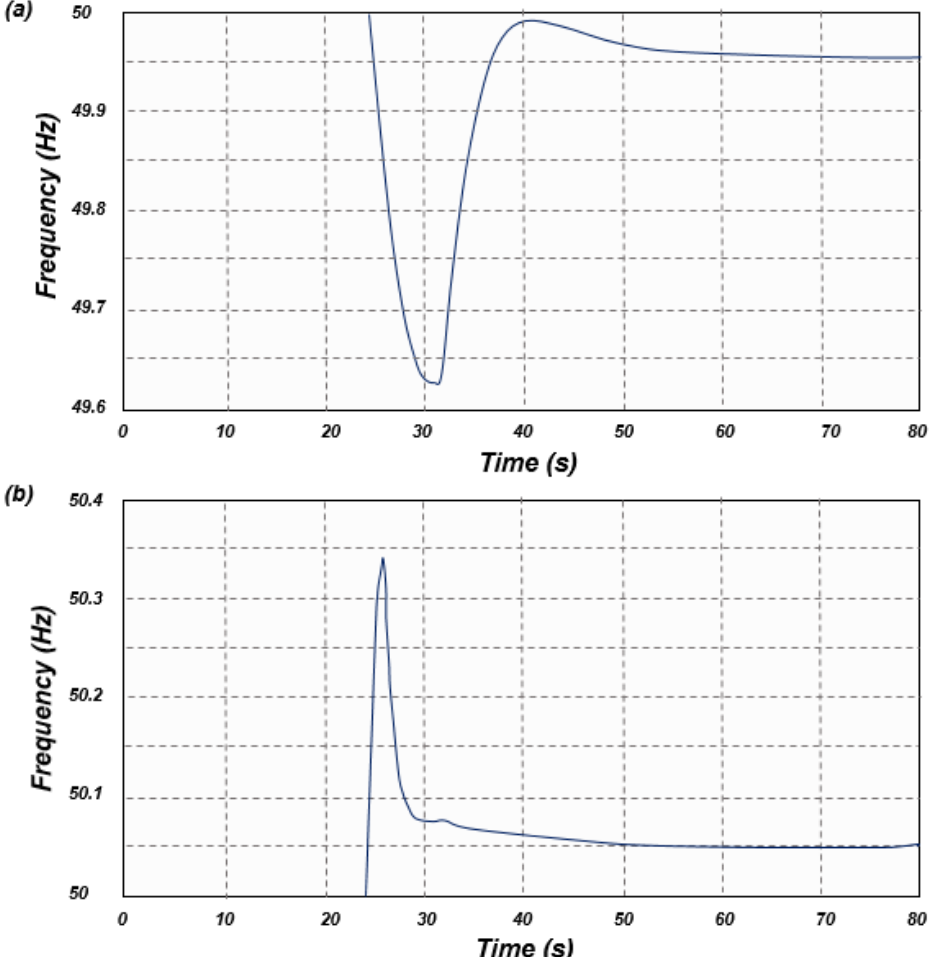
Figure 4. Frequency response signals: ( a ) with negative deviation, ( b ) with positive deviation (redrawn from [16]).